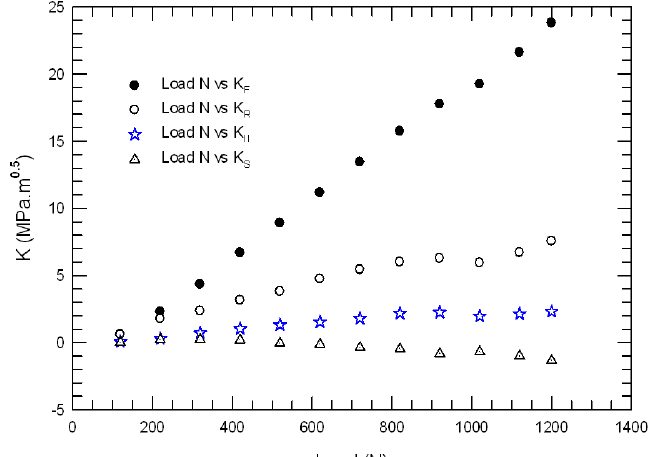
: Stress intensity values given by the mixed-mode CJP equation, with K F defined perpendicular to the 45° slant crack and K II Figure 4 defined parallel with the slant crack in the CT